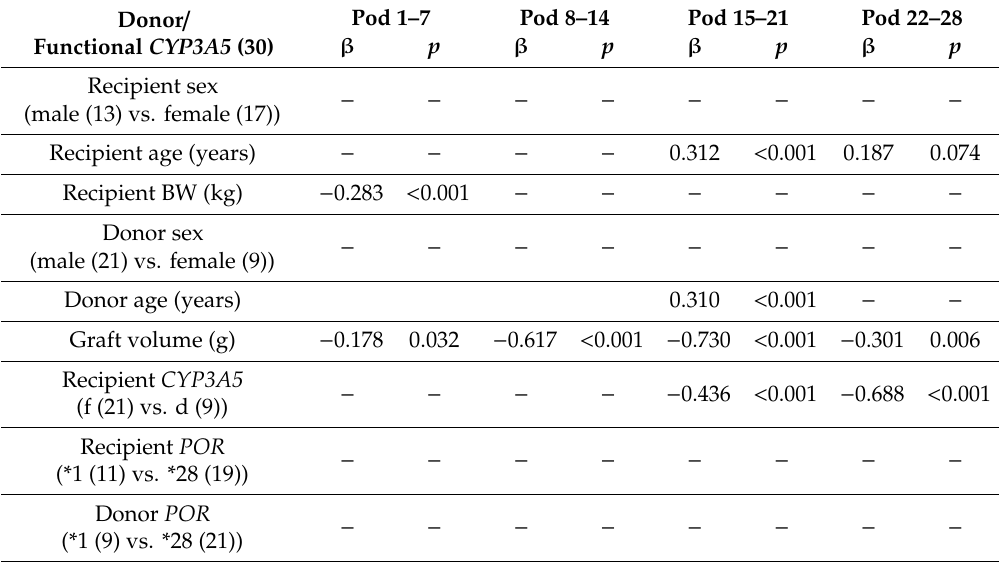
Table 6. Multiple regression analysis of cases in which donors had functional CYP3A5.